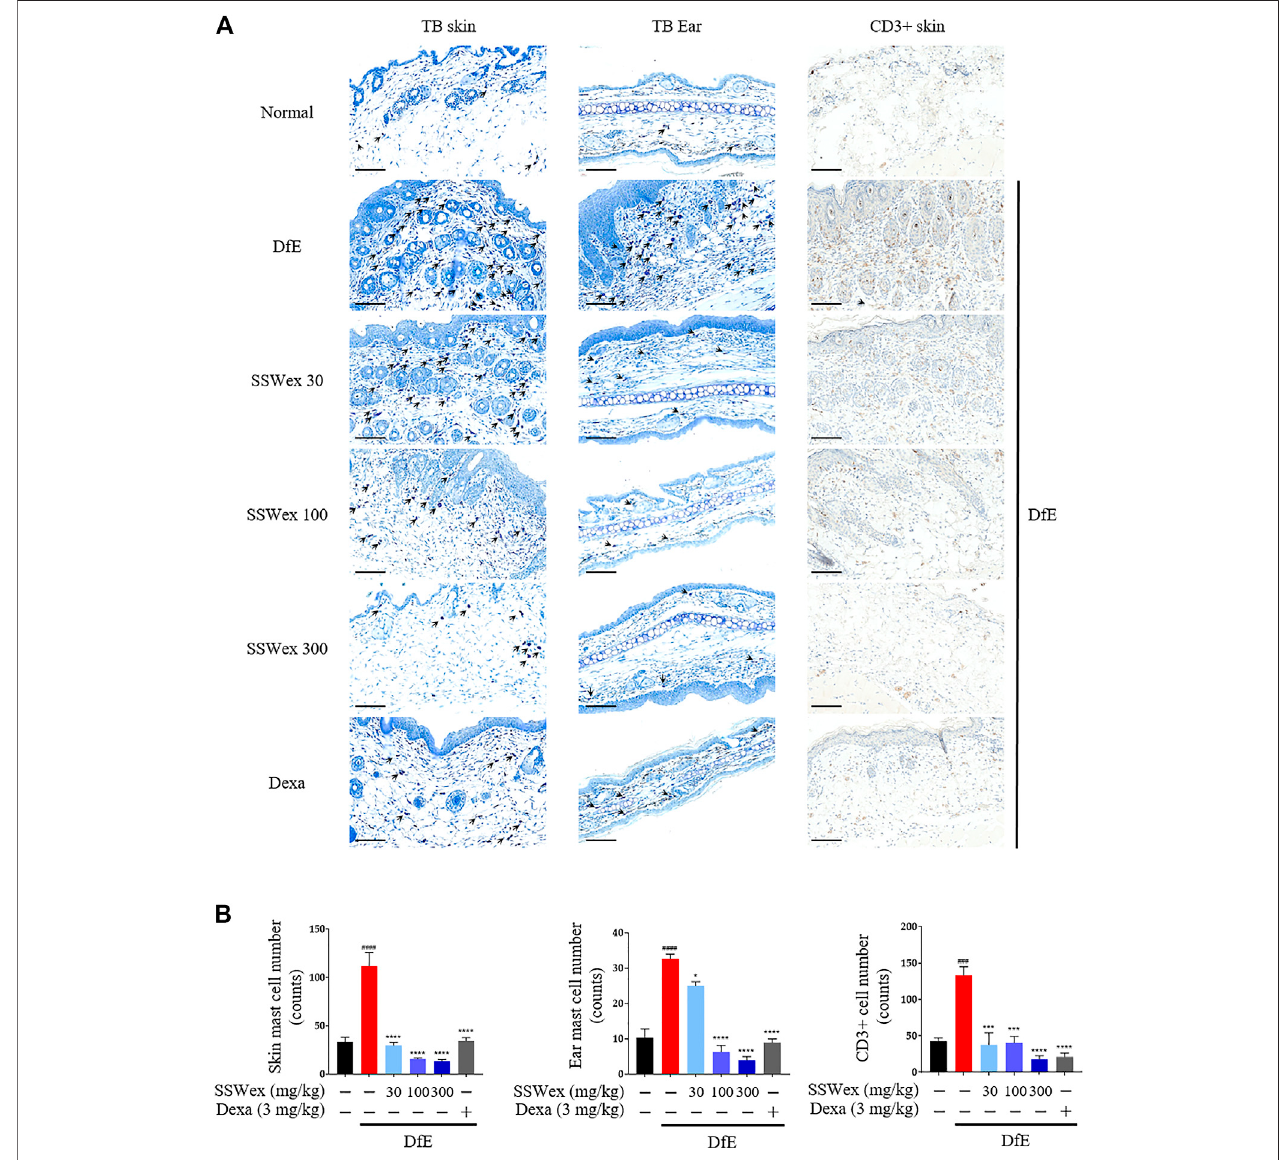
FIGURE3| EffectofSSWexonthein fi ltrationofmastandTcellsinskinlesionsofDfE-treatedNC/Ngamice. (A,B) Sectioneddorsalskinandearswerestainedwith toluidinebluetoevaluatemastcellin fi ltration.Dorsalskintissuesectionswereimmunostainedwithanti – CD3antibodiestocon fi rmT-cellin fi ltration.Thestainedsections were observed under a microscope at ×400 magni fi cation. Scale bar = 100 μ m. Data are represented as the mean ± S.E.M. ( n = 6). # p < 0.05, ## p < 0.005, ### p < 0.0005, and #### p < 0.0001 vs. the normal group; * p < 0.05, ** p < 0.005, *** p < 0.0005, and **** p < 0.0001 vs. the DfE group.